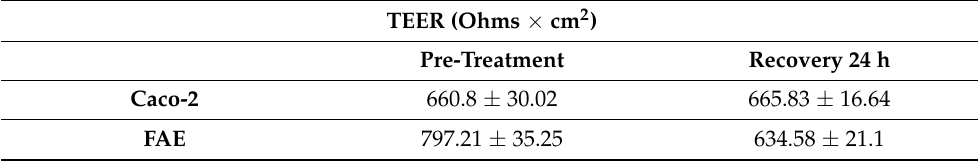
Figure 5. Impact of bioaccessible fractions of the two Fe formulations on apparent permeability (Papp) of Caco-2 cell monolayer model ( A ) after 3 h of incubation. Effect of Fosfosoma ® on Papp of Caco-2 cell monolayer and FAE models ( B ) after 3 h incubation. Intestinal epithelium integrity was further assessed by TEER measurement. Table 9. TEER values in Caco-2 and human intestinal follicle-associated epithelium (FAE) monolayers at the end of the 3 h incubation with bioaccessible fractions of Ferro Fosfosoma ® . Results are expressed as mean ± standard